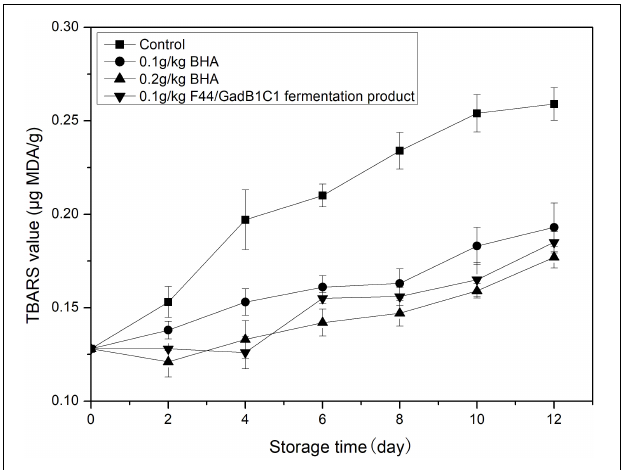
FIGURE 5 | Lipid oxidation evaluation of the pork treated with BHA and F44/GadB1C1 fermentation product during storage at 4 ◦ C.